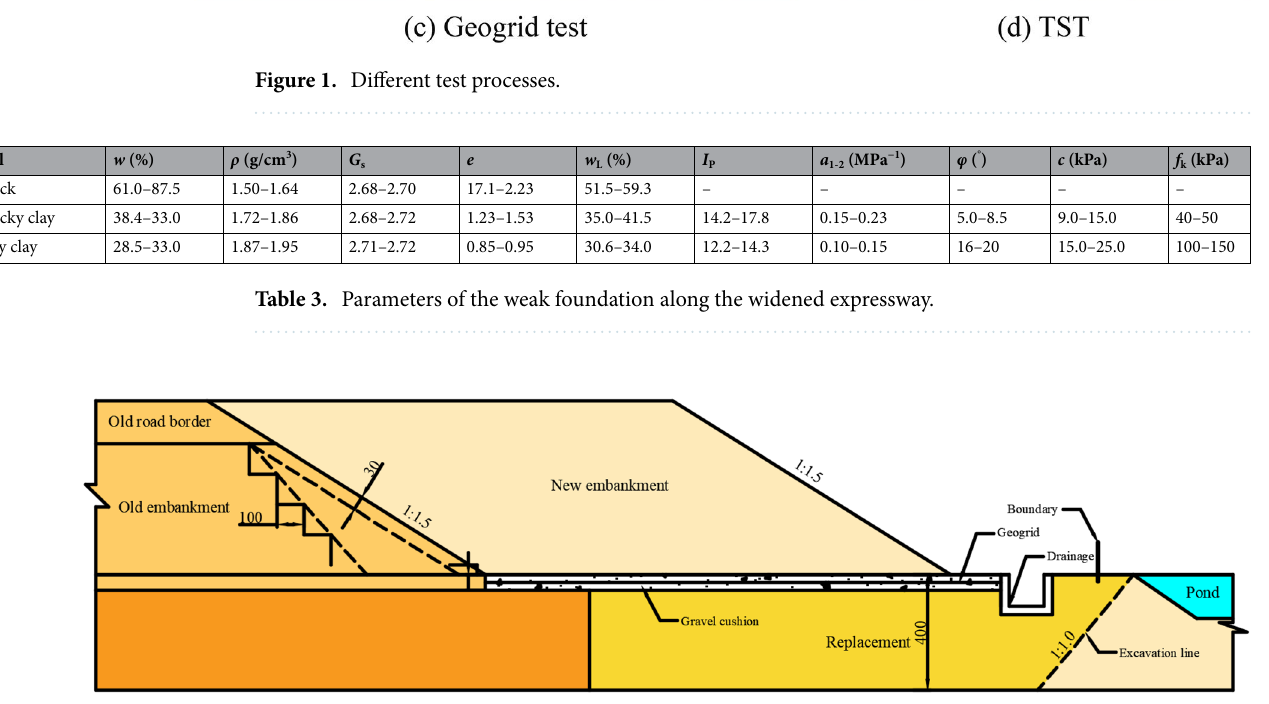
Figure 2. Layout of the widening